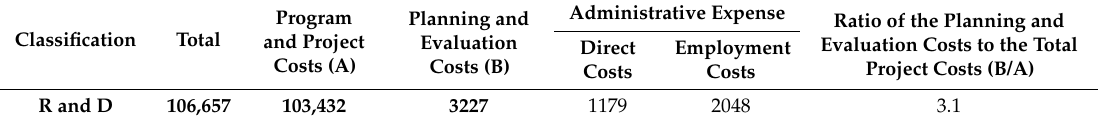
Table 2. Current status of R and D management-agency budgets in 2017 (Unit: KRW million, %).